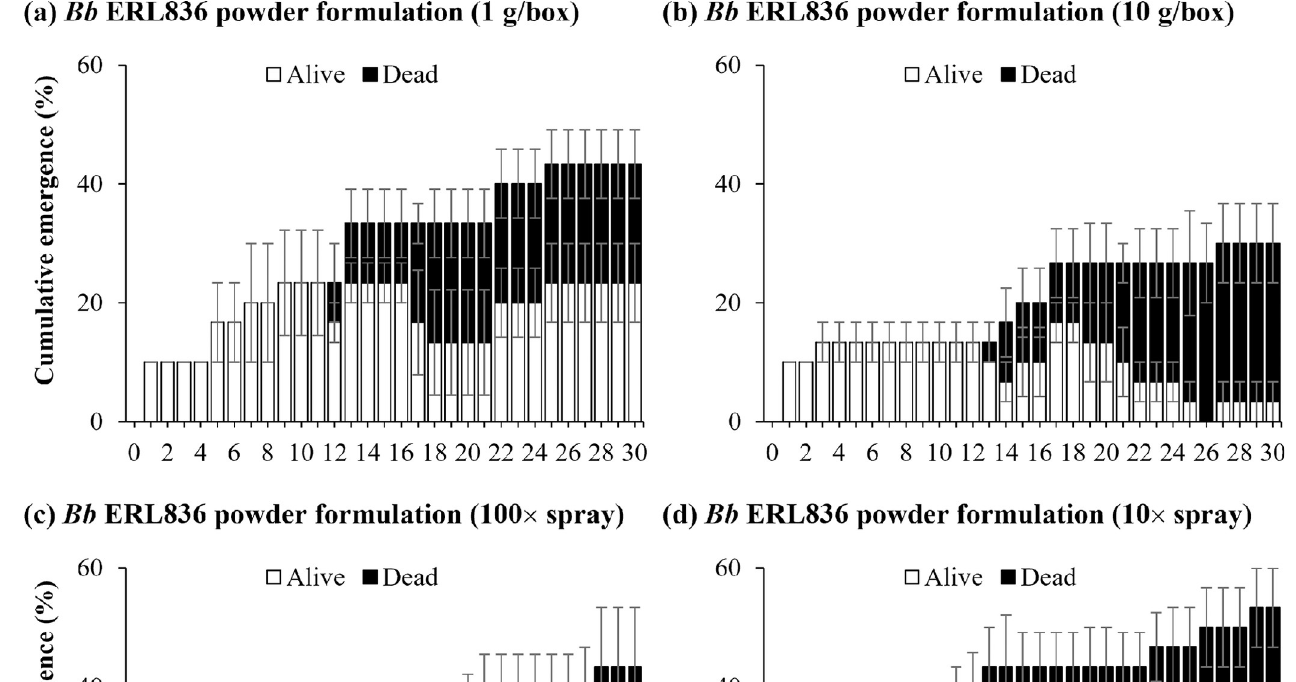
Fig 3. Insecticidal activity of B . bassiana ERL836 against M . alternatus adults using formulated fungal powder pre–treatment of pine logs artificially infested with larvae in greenhouse conditions. The fungal powder formulation was directly powdered on the logs at 1g/box (a) and 10 g/box (b). Secondly the